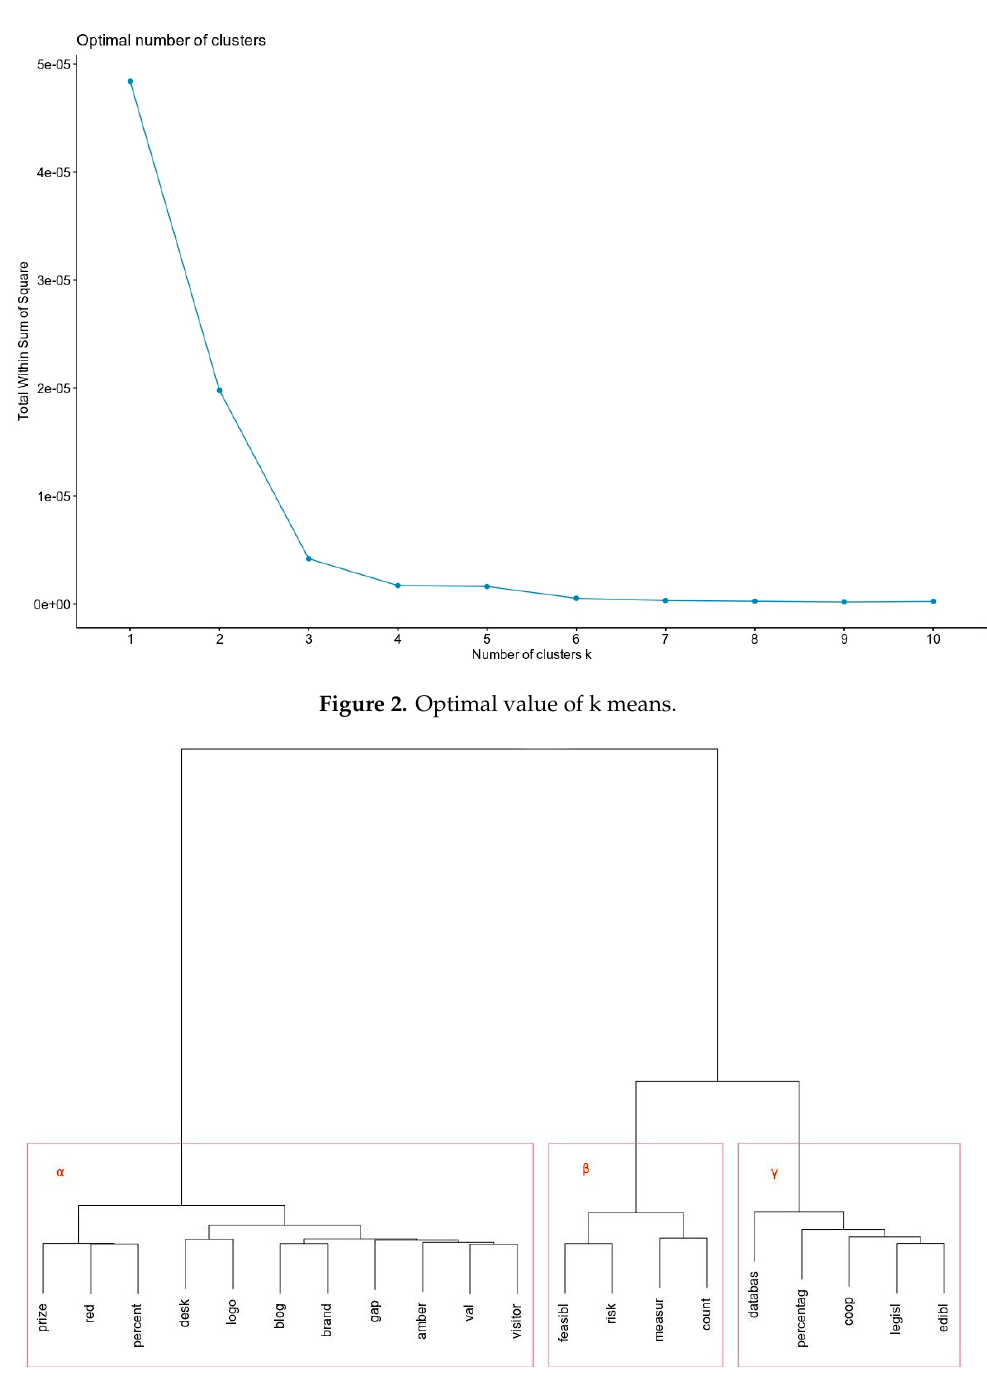
Figure 3. Hierarchical clustering of 20 terms using Tf-Idf weighting.